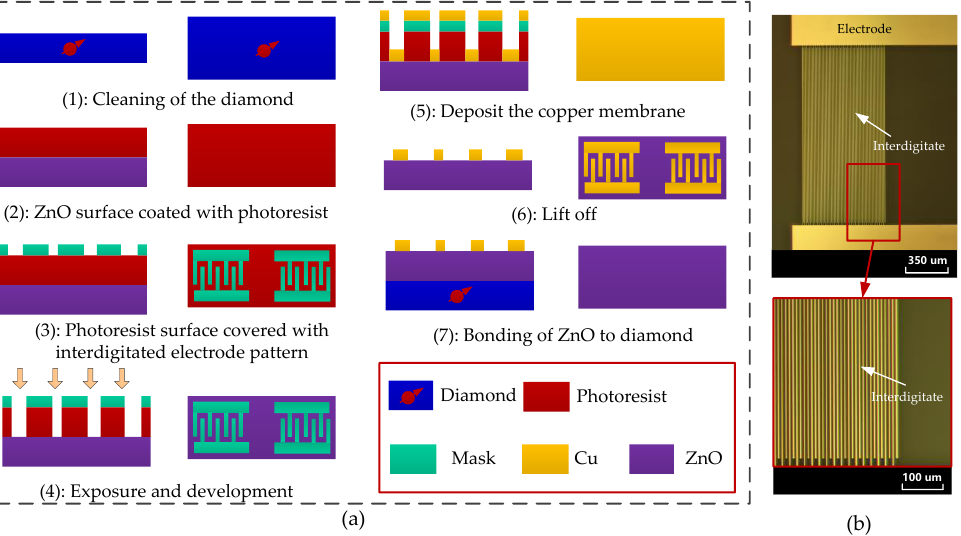
Figure 17. MEMS implementation of the phonon piezoelectric device of the NV center. ( a ) MEMS process. ( b ) Optical micrograph.